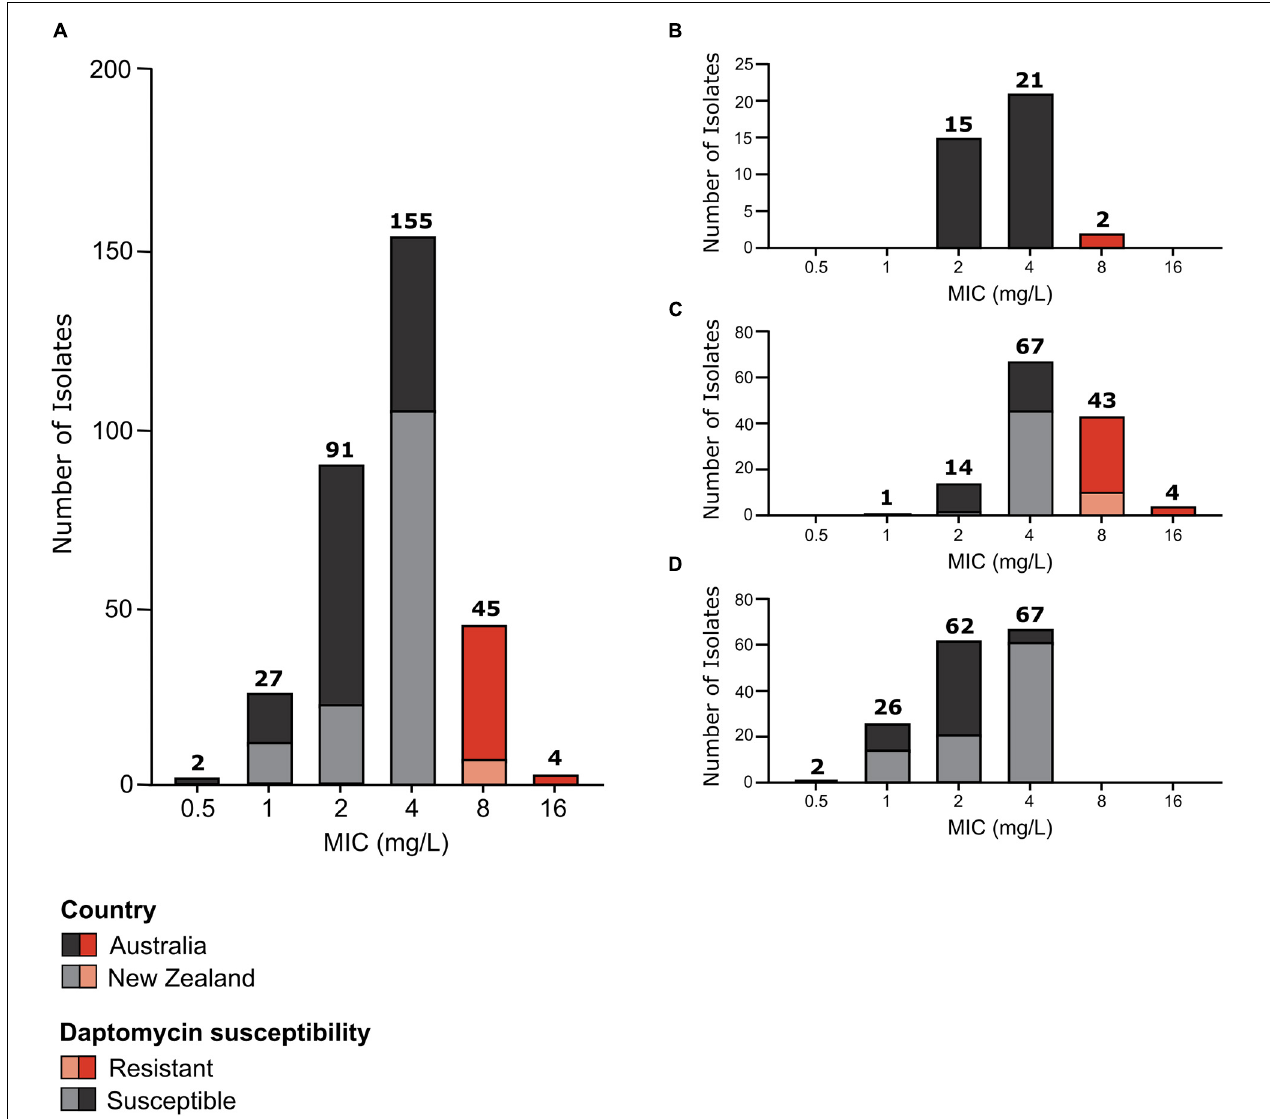
FIGURE 1 | Daptomycin susceptibility of E. faecium study isolates. Daptomycin MIC distribution of (A) all study isolates ( n = 324); (B) VSEfm isolates ( n = 38); (C) vanA -VREfm isolates ( n = 129); and (D) vanB -VREfm isolates ( n = 157). Australian isolates are represented by dark grey and dark red blocks and New Zealand isolates are represented by light grey and light red blocks. Daptomycin-susceptible MICs are shown in grey (MIC < 8 mg/L) and daptomycin-resistant MICs are highlighted in red (MIC ≥ 8 mg/L). The number of isolates with each MIC value shown on the x -axis is displayed above the respective bars.